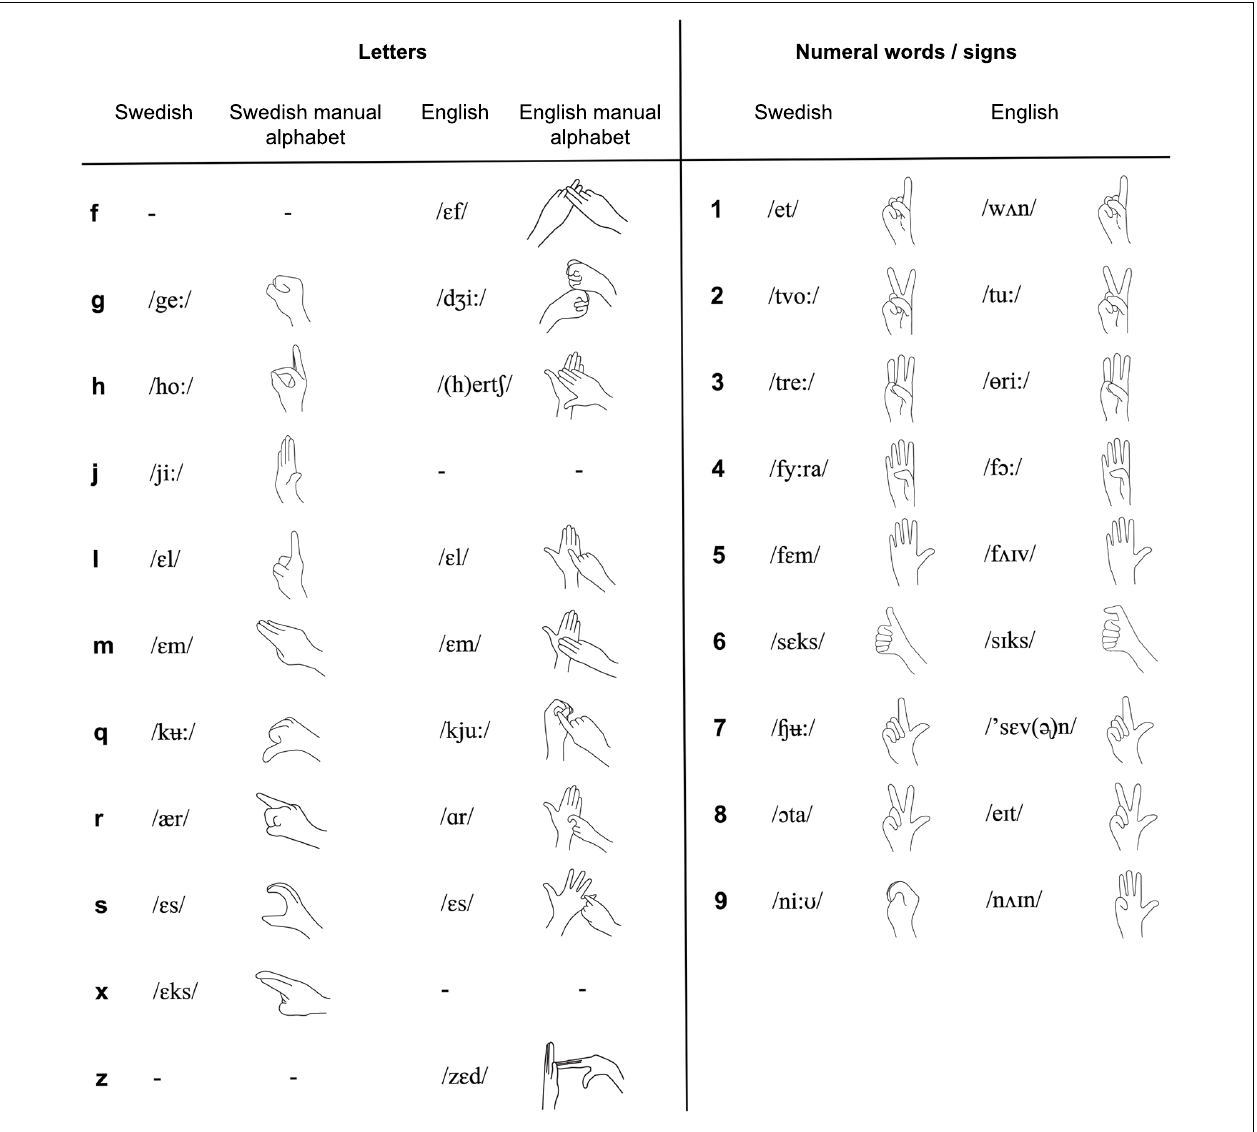
FIGURE 1 | Phonology of the nine fingerspelled letters of the Swedish manual alphabet in Experiment 1, the nine fingerspelled letters of the British manual alphabet used in Experiment 2 and the nine manual numerals according to the Swedish and British systems for the digits 1–9 and numeral words and letters as expressed by the international